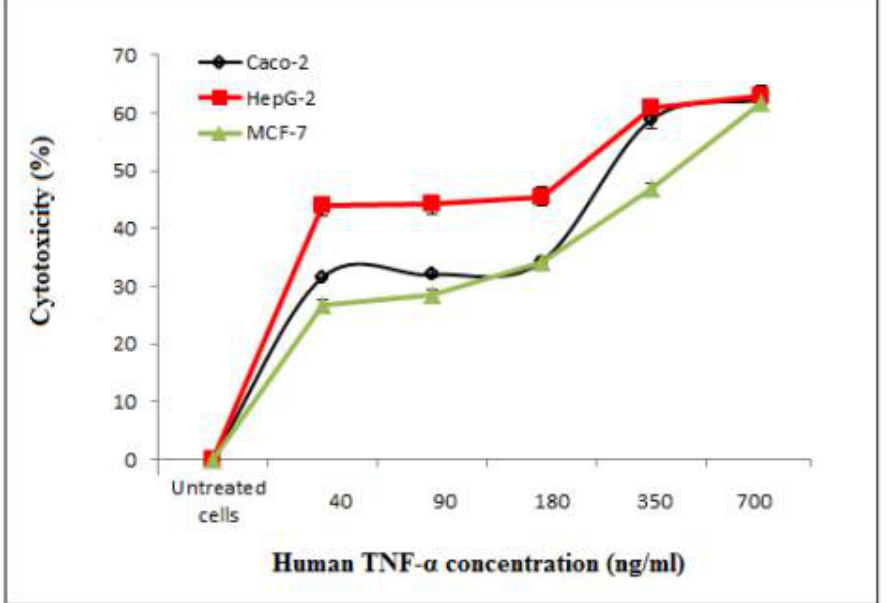
Figure 12. Inhibitory effect of cell-free synthesized human TNF-α on the proliferation of Caco-2, HepG-2 and MCF-7 human cancer cell lines. Table 12. IC 50 and EC 100 of cell-free synthesized human TNF-α against human cancer cell lines. Human TNF-α